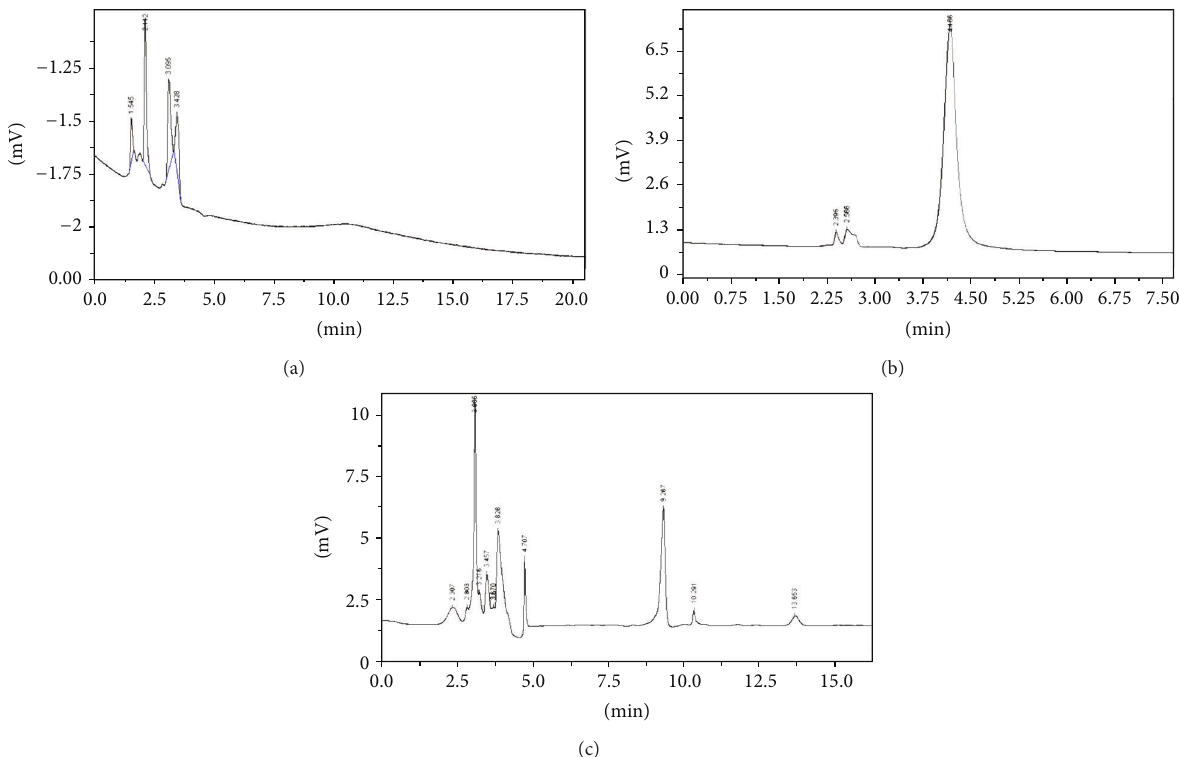
Figure 2: HPLC chromatogram of standard matrine in different mobile phase condition. (a) Methanol: water = 14:86; (b) methanol: 0.01 mol/LKH 2 PO 4 = 20 :80 (PH = 6 ∼ 7); (c) acetonitrile: anhydrous ethanol: 3% H 3 PO 4 =